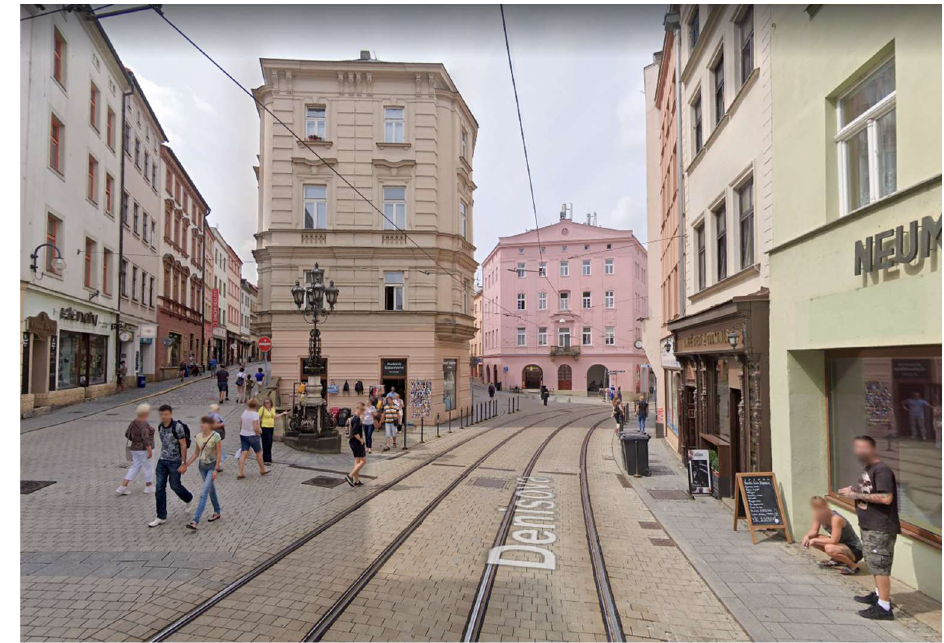
Figure 2. The historic center environment.